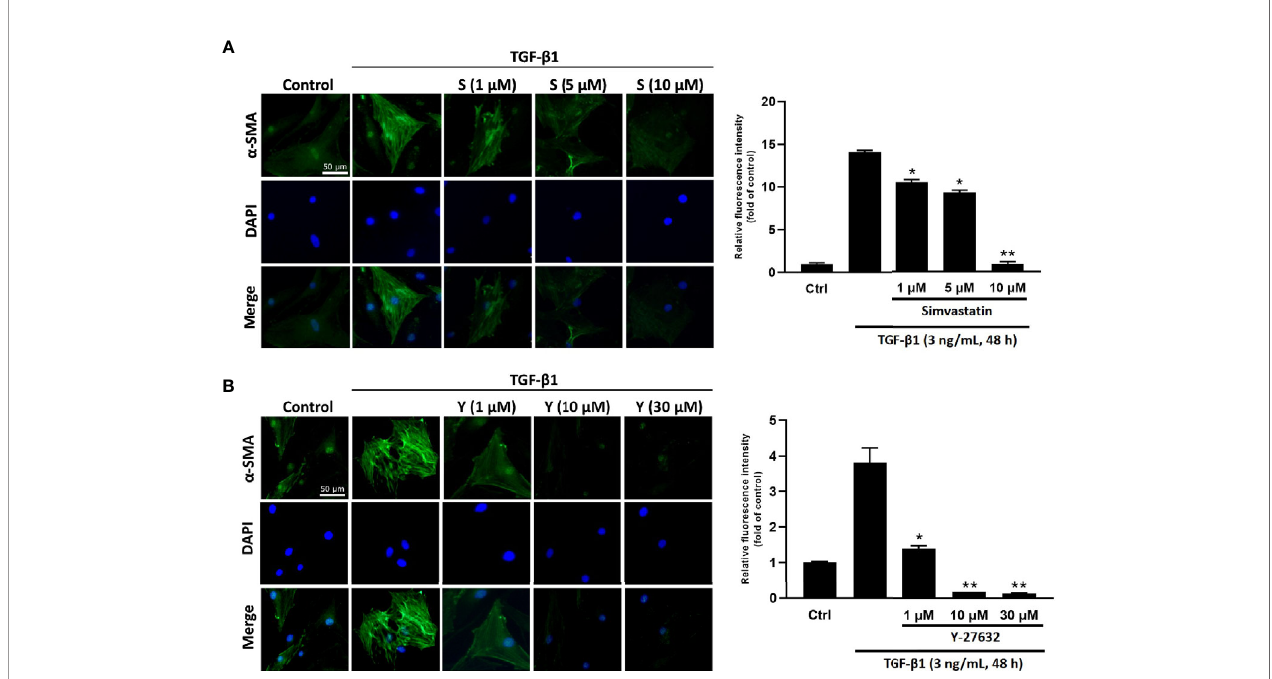
FIGURE 1 | Immunocytochemical characterization of transforming growth factor- b (TGF- b )-induced a -smooth muscle actin ( a -SMA) expression in Graves ’ ophthalmopathy (GO) orbital fi broblasts. Primary cultured GO orbital fi broblasts were stimulated with 3 ng/mL TGF- b 1 for 48 h with or without a 1-h pretreatment with different concentrations of simvastatin (1, 5, 10 m M) (A) or ROCK inhibitor Y-27632 (1, 10, 30 m M) (B) . a -SMA expression was detected using immuno fl uorescence staining (green). The bar charts show mean data of relative fl uorescence intensity of a -SMA presented as the fold of control. *p < 0.05, **p < 0.01 compared to cells treated with TGF- b 1 alone. S = simvastatin; Y =